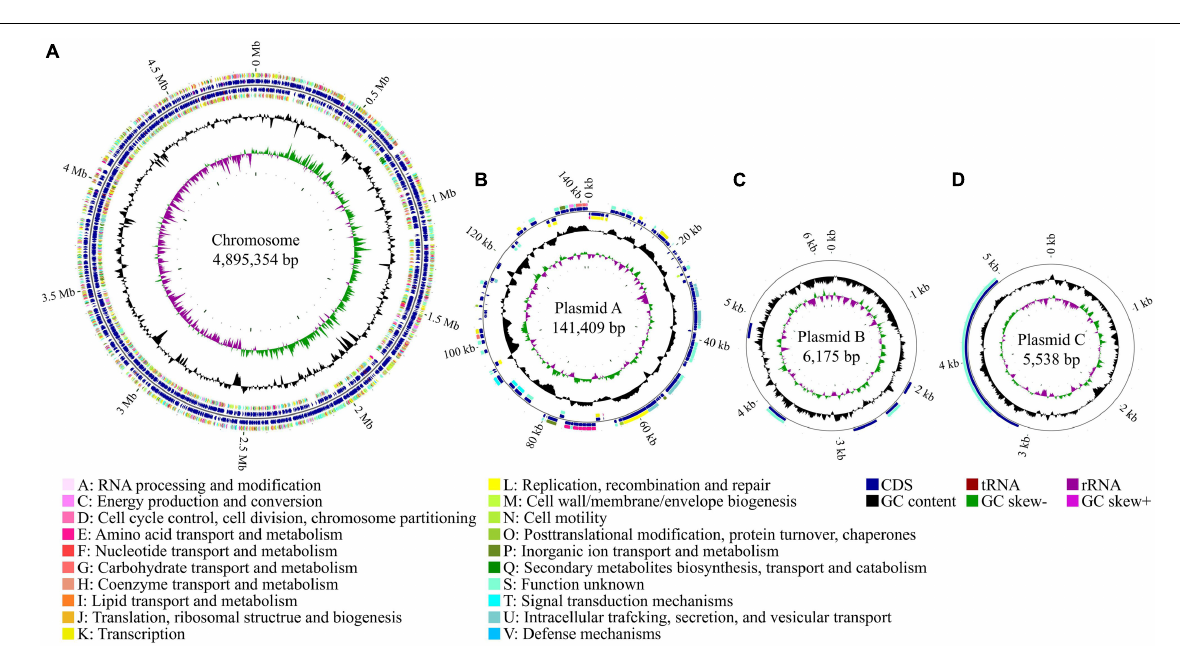
Frontiers in Microbiology |